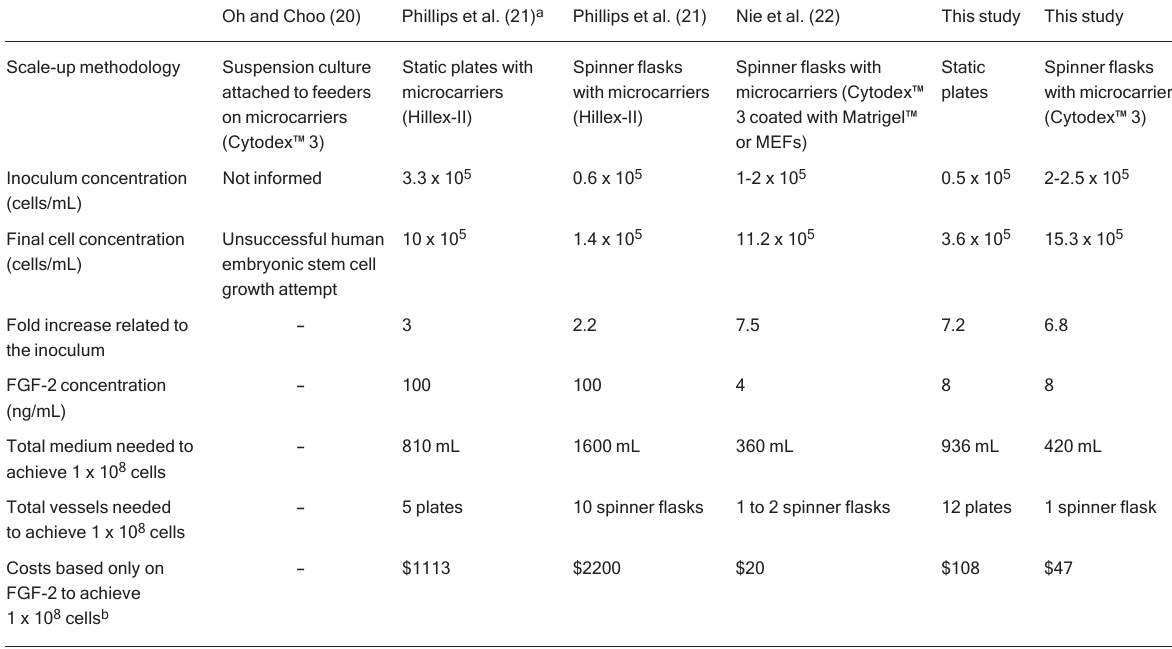
Table 1. Overview of studies using microcarriers for the expansion of human embryonic stem cells and comparison with data of the present